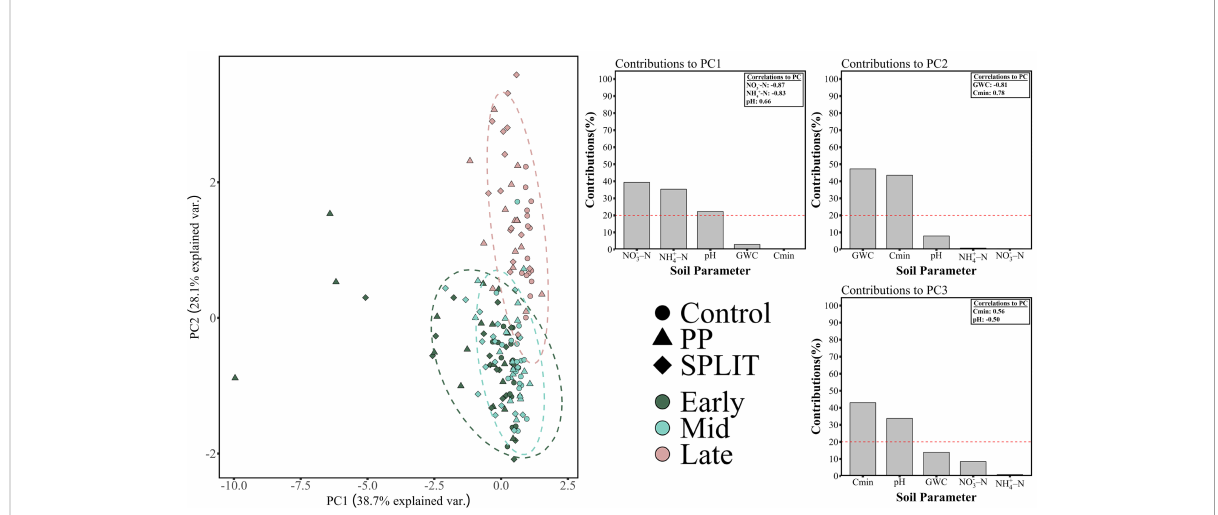
FIGURE 1 Principal components analysis of soil chemical characteristics in the fi nal year of the study. Soil characteristic contributions to the top three principal components are presented with correlation coef fi cients for the signi fi cant contributors to each PC. Control, no-added nitrogen (N) fertilizer; PP, pre-plant fertilizer application at a rate of 168 kg N ha -1 ; SPLIT, 40% preplant, 60% mid-season application of N fertilizer at a total rate of 168 kg N ha -1 . Early, early-season sampling (June); Mid, mid-season sampling (August); Late, late-season sampling (October). GWC, gravimetric water content; Cmin, mineralizable carbon content; NO − 3 -N, nitrate; NH + 4 -N